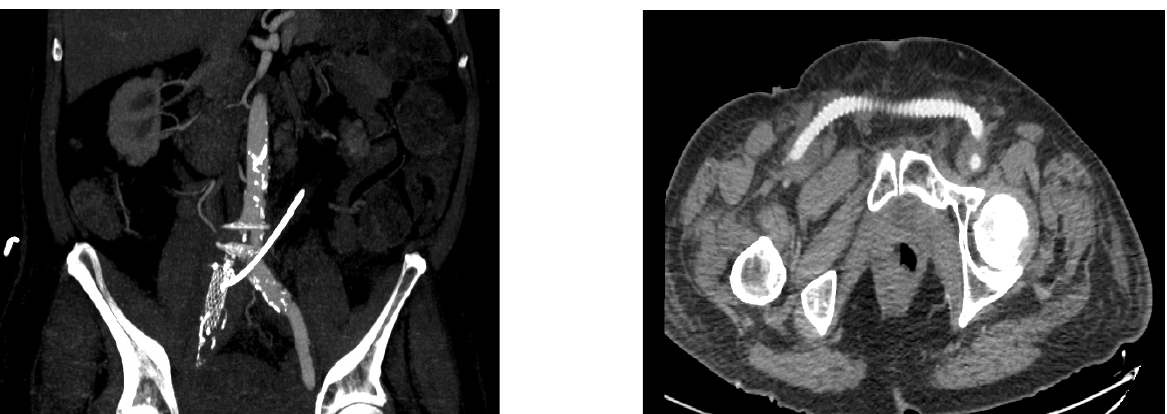
Figure 3. ( Right ) common iliac artery ligation with femoral-to-femoral artery extra-anatomic vascular reconstruction after failure of endovascular treatment — Angio CT aspect (( left ): maximum intensity projection reconstruction describing the absence of contrast media in the right common iliac artery after ligation following failure of endovascular approach; right: axial section of a femoral-to-femoral artery extra-anatomic vascular reconstruction).